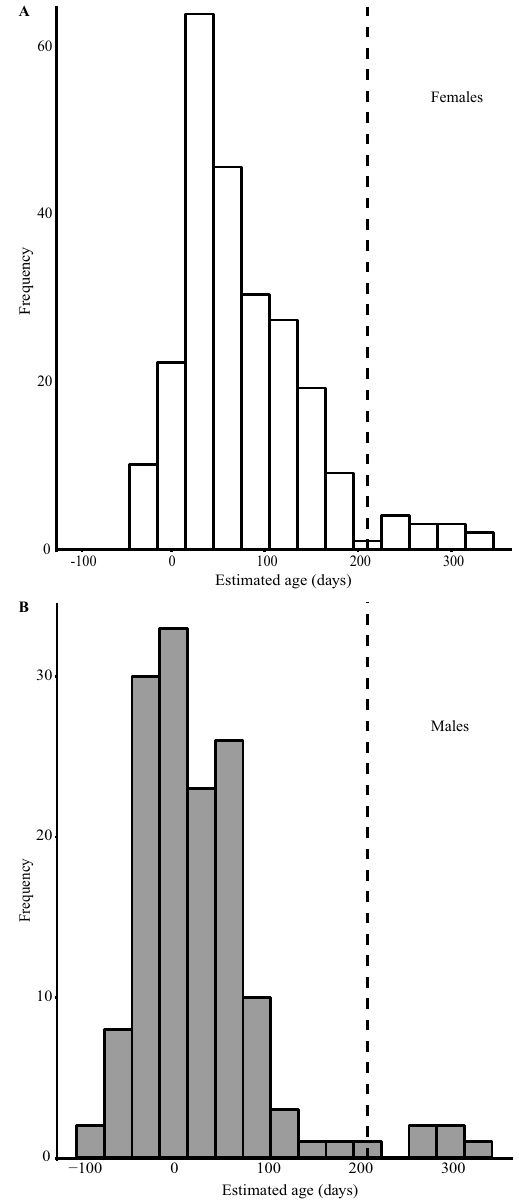
Figure 3. Frequency distributions of estimated ages of female ( n = 238; A ) and male ( n = 143; B ) P. downsi flies captured at a lowland site on Santa Cruz Island, Galapagos from February 2015 through March 2016. The vertical dotted line marks 210 days, which corresponds to the length of a typical interbreeding season, during which host availability for P. downsi is